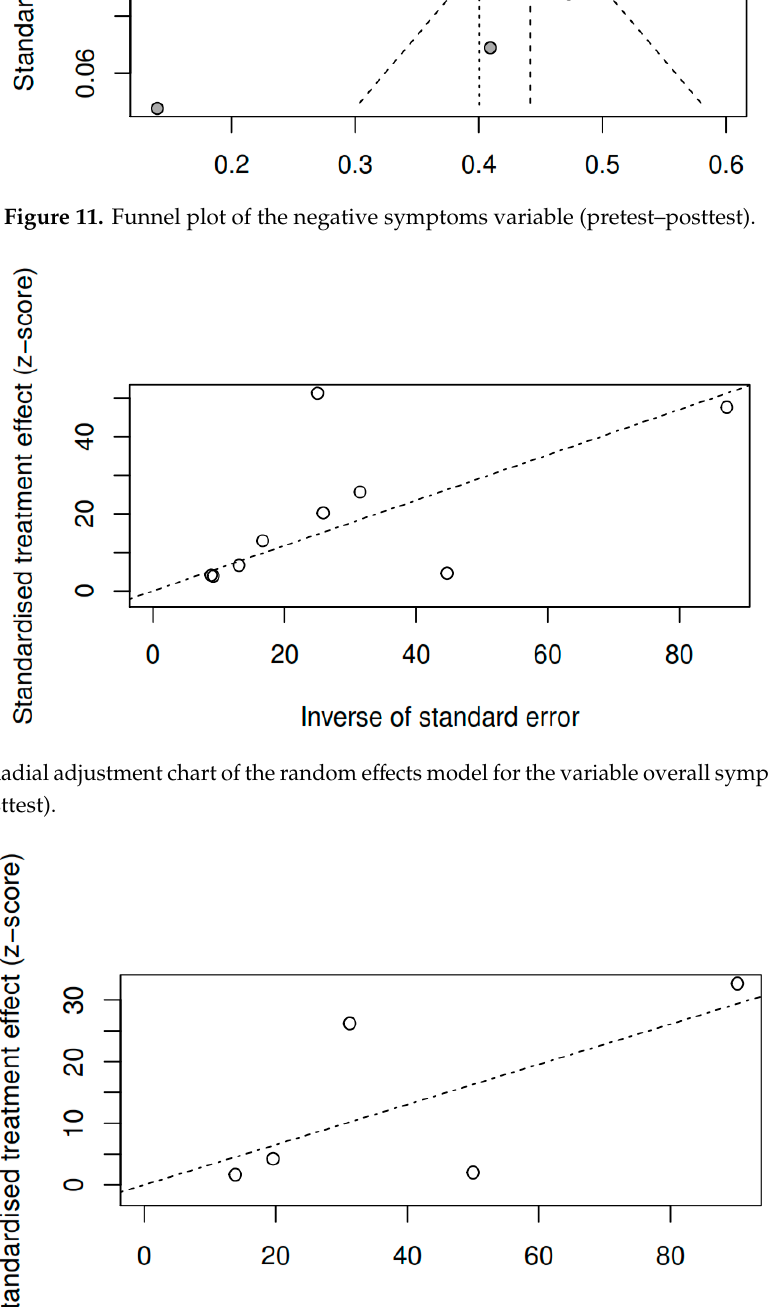
Figure 13. Radial adjustment chart of the random effects model for the variable positive symptoms (pretest–posttest).